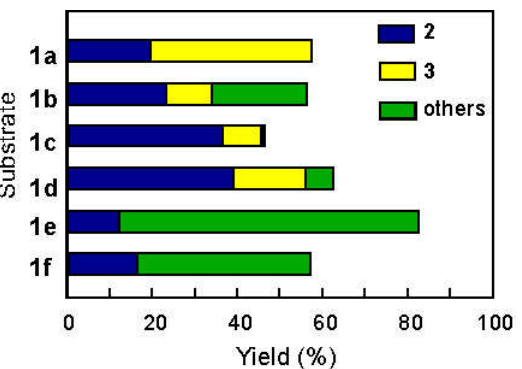
Figure 4. Reactions of CO with various amino alcohols. Reaction conditions: amino alcohol, 60 2 mmol; CO 10 MPa; ethanol, 4 cm 3 ; BMIM-Br, 11.4 mmol; K CO , 0.7 mmol; temperature, 150°C; 2 2 3 time, 6